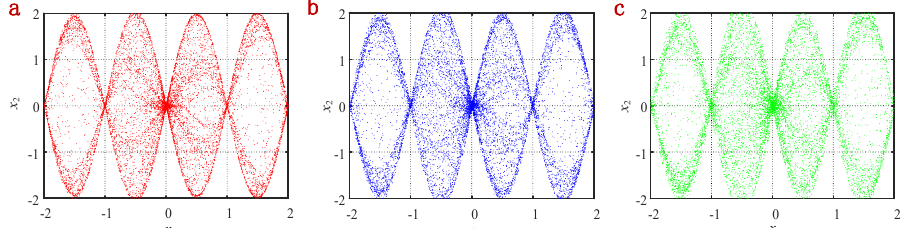
Figure 1. Phase diagrams of the fractional 2D-SIMM with different derivative orders. ( a ) q = 0.98. ( b ) q = 0.95. ( c ) q =